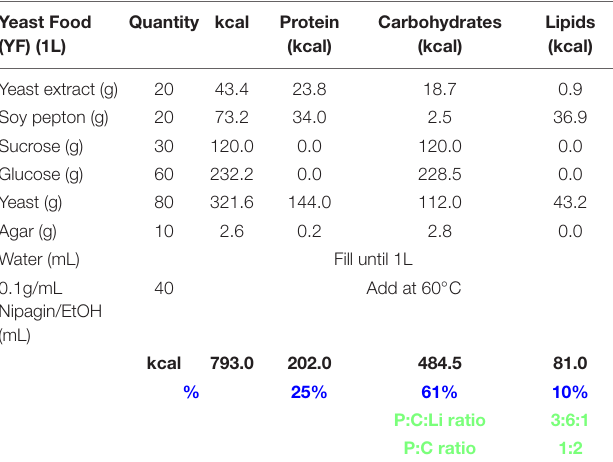
P:C:Li ratio 1:4:1 P:C ratio 1:4 Recipe for 1liter of corn food. The calories (in kcal) brought by each ingredients have been calculated. At the bottom, in black bold, the totals (in kcal) aer shown. In blue are indicated the proportions (%) of kcal of proteins, carbohydrates, or lipids on the total amount of calories. In green are shown the protein: carbohydrate: lipid and protein: carbohydrate ratios. EtOH, ethanol; P, proteins; C, carbohydrates; Li,